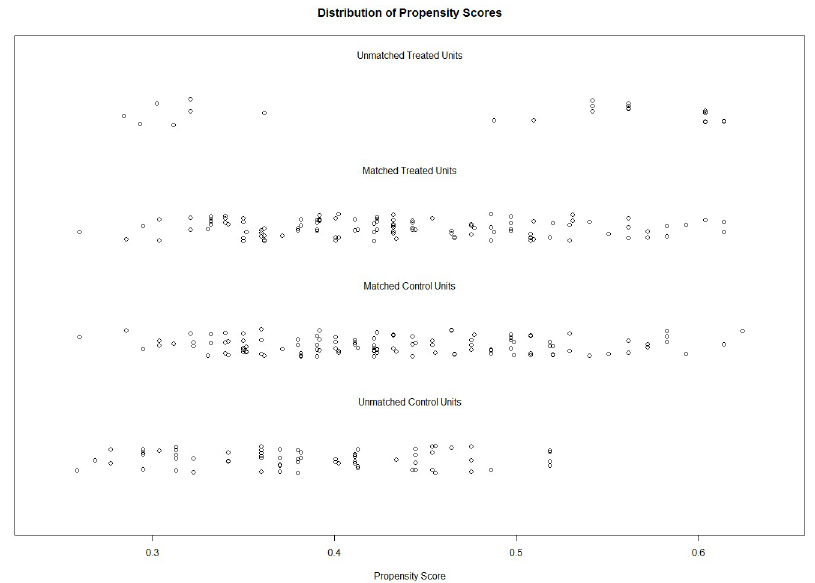
Fig 6. Propensity score distribution in Analysis 1b for the overlap between the 2012 sample and the 2020 sample. Unmatched units were discarded after the matching procedure to ensure an optimal overlap in propensity scores of the two